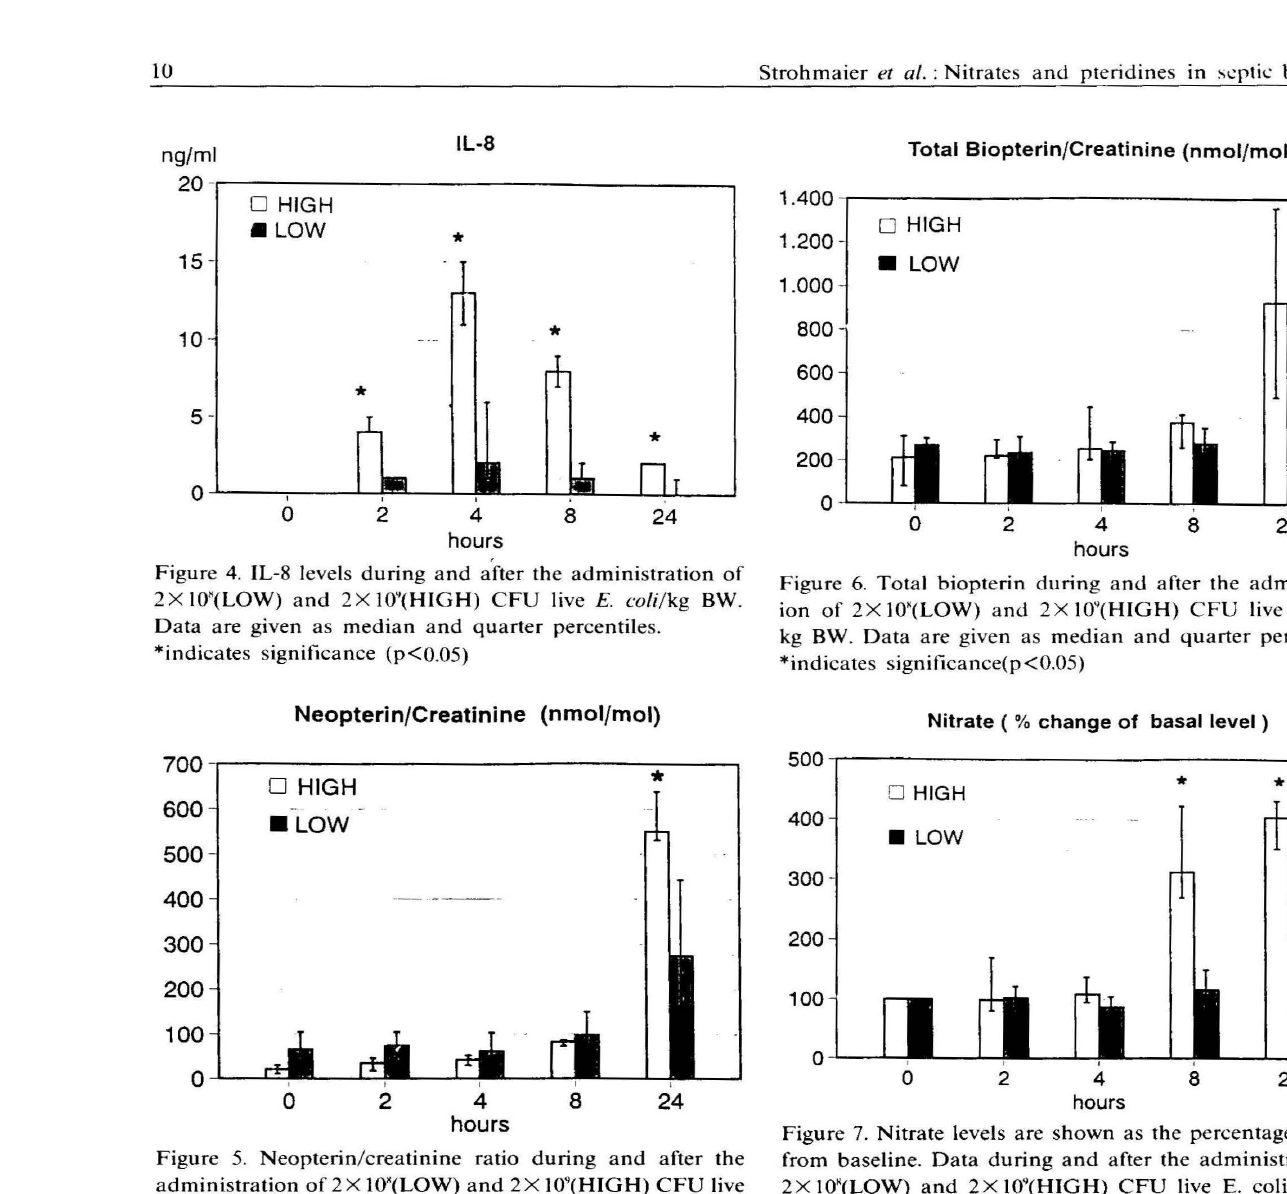
Figure 7. Nitrate levels are shown as the percentage change from baseline. Data during and after the administration of 2X IO"(LOW) and 2X 10 9 (HIGH) CFU live E. coli/kg BW. Data are given as median and quarter